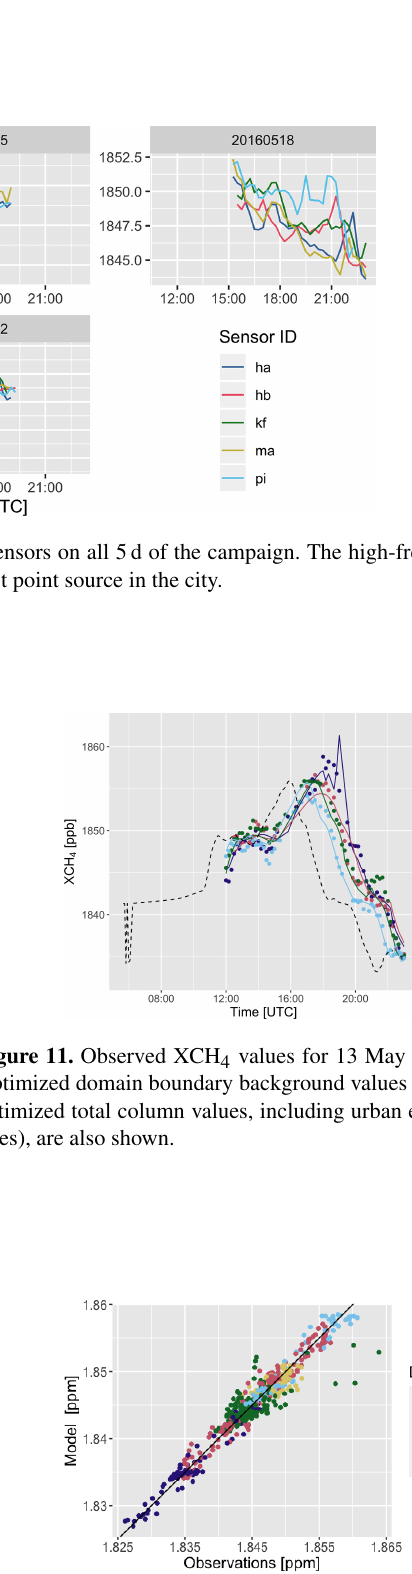
Figure 12. Optimized model correlation with the 5d observations. The black curve is a 1–1 line. Each point represents a 15min av- erage from a single sensor. Observations with a significant point- source influence have been